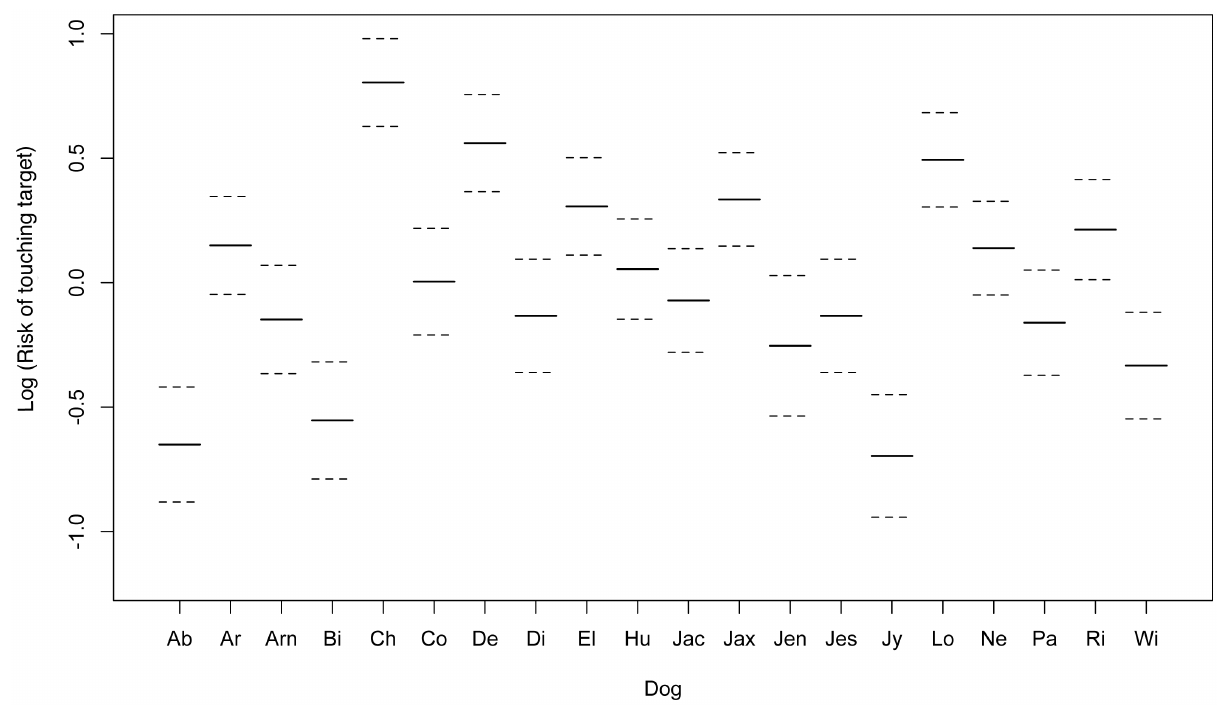
Figure 3. The risk of touching the target before the 10-second time out for all cues is shown on the y-axis in a log scale, and individual dogs (n=20) are shown on the x-axis. Standard errors are shown with broken lines. Some dogs are much more likely to touch the target than others. For example, dogs ‘‘Ab’’, ‘‘Bi’’ and ‘‘Jy’’ have a low likelihood of touching the target regardless of cue, and dogs ‘‘Ch’’, ‘‘De’’ and ‘‘Lo’’ have a high likelihood of touching the target regardless of cue.